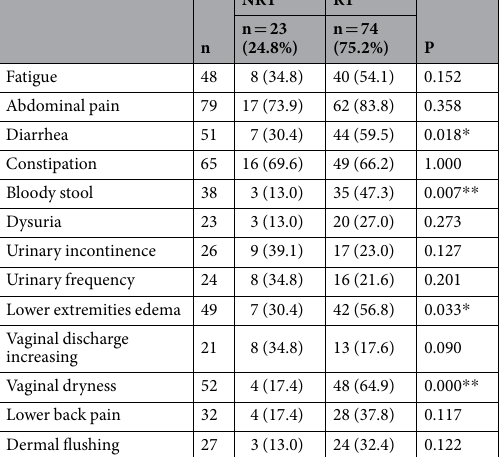
Table 3. Comparison of long-term side effects between two study groups. * P < 0.05. ** P <